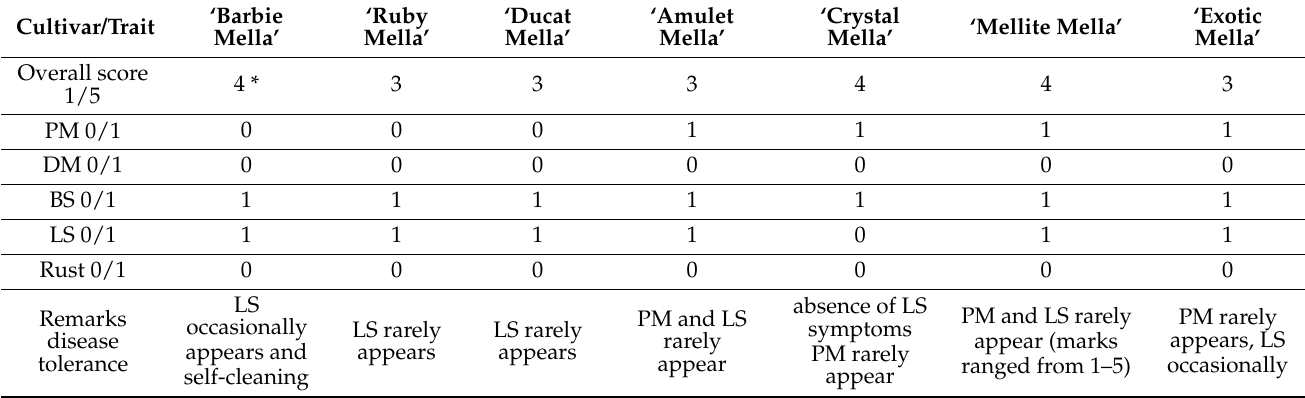
Table 5. Disease tolerance of the investigated ‘Mella’ rose collection in three-year period.